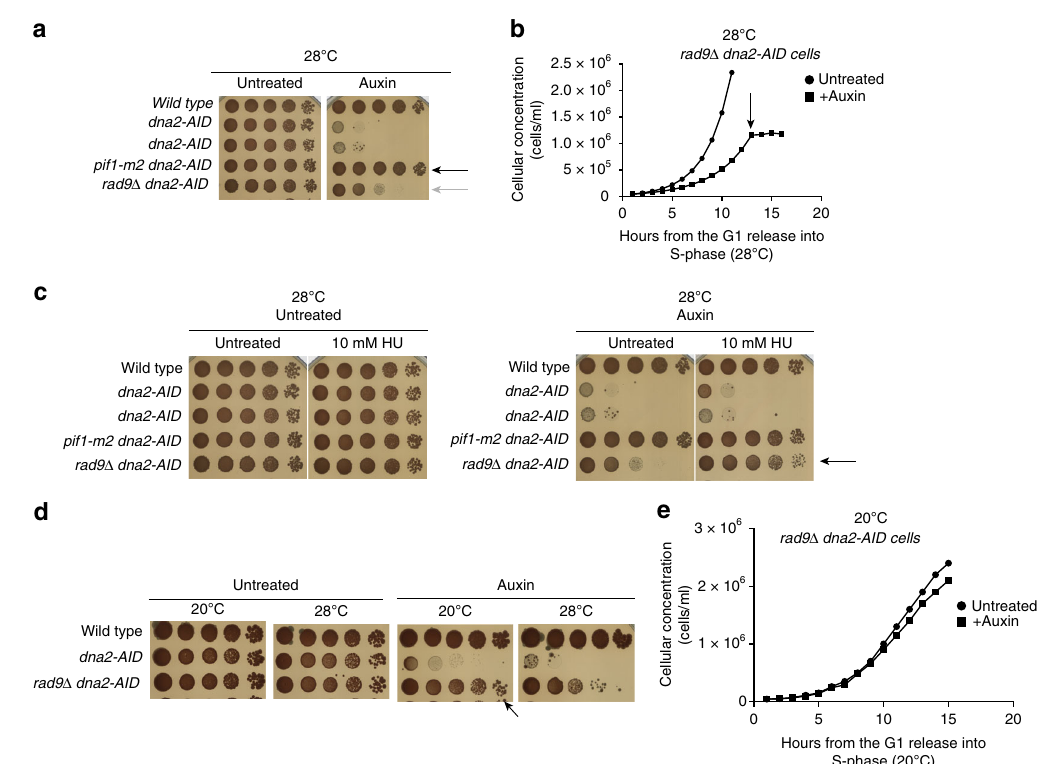
Fig. 2 Fork speed and Pif1 induce cell death in Dna2-depleted cells. a In-plate cell survival assay. The indicated yeast strains were depleted (auxin) or non- depleted (untreated) for Dna2. Black and grey arrows indicate suppression of cell lethality induced by pif1-m2 mutation or RAD9 deletion. b In liquid growth curve of dna2-AID rad9 Δ cells depleted for Dna2 in G1 (auxin) or non-depleted (untreated) and released into the cell cycle. The black arrow indicates growth arrest in dna2-AID rad9 Δ cells depleted for Dna2. c , d In-plate cell survival assay. Black arrows indicate that low HU dose or low temperature suppress the cell lethality induced by depletion of Dna2 in dna2-AID rad9 Δ cells. e Same experiment as in ( b ), but cells were released at 20 °C. In this condition, dna2-AID rad9 Δ cells depleted for Dna2 do not arrest cell growth even after 15 h from the G1